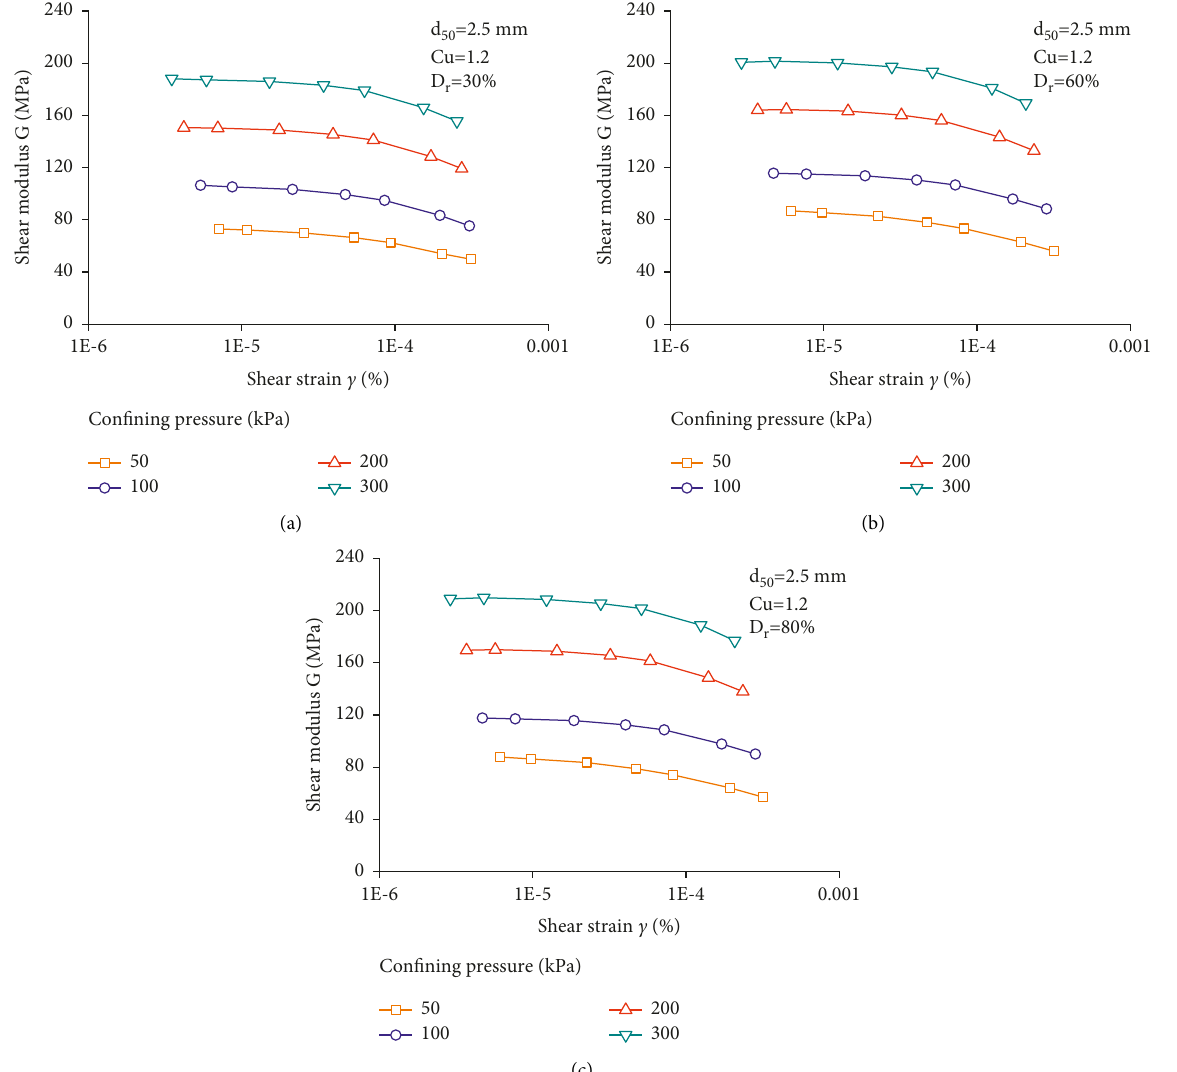
Figure 5: Shear modulus G and shear strain c for calcareous sand with d state. (b) Medium dense state. (c) Dense